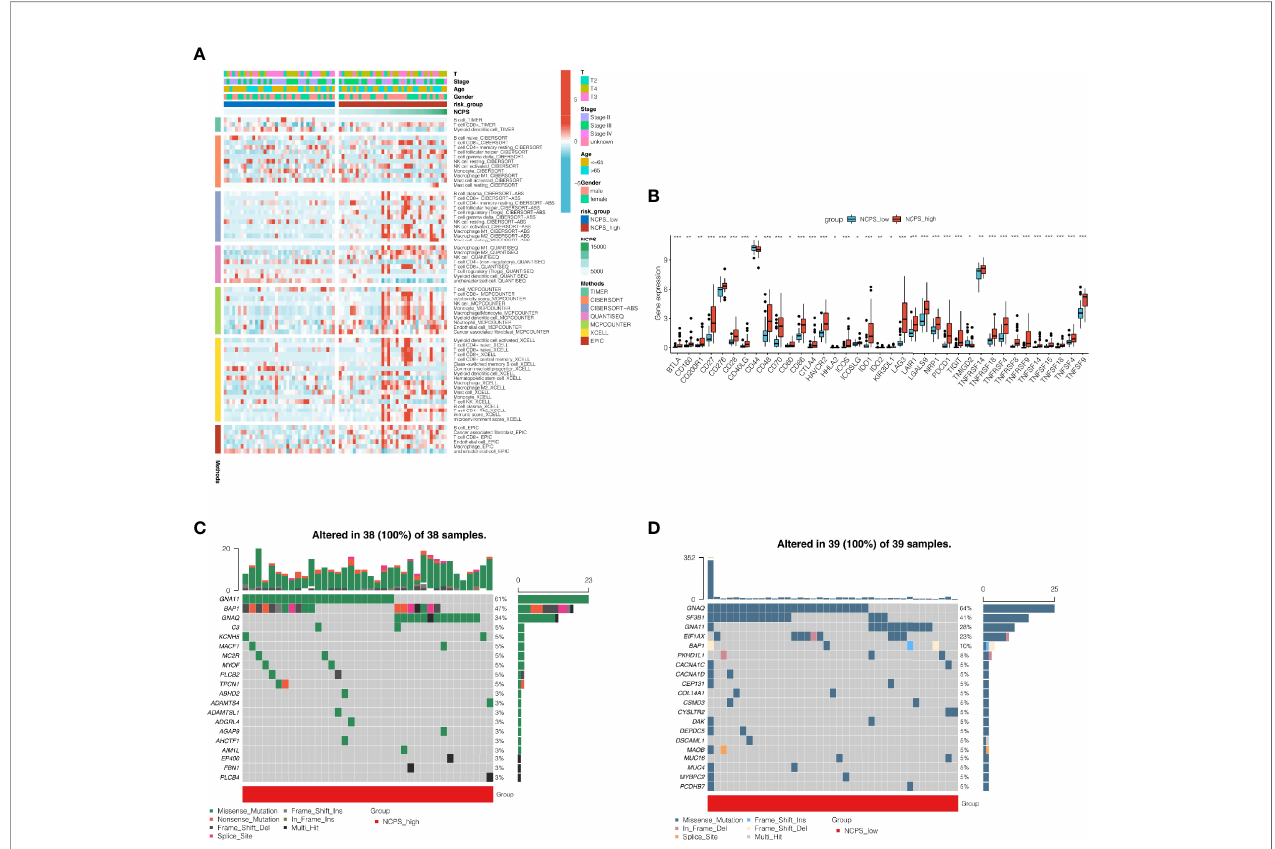
FIGURE 4 | Immune in fi ltration analysis and mutantion landscape. (A) Heat map of immune cell in fi ltration in high NCPS group and low NCPS group. (B) Expression of immune checkpoint related genes in high -NCPS group and low -NCPS group. The results showed that the expression trend of immune checkpoint related genes was higher in the high-NCPS group. (C) Mutation landscape of TCGA cohort. (D) Mutation landscape of GSE84976 cohort. *P < 0.05; **P < 0.01; ***P <